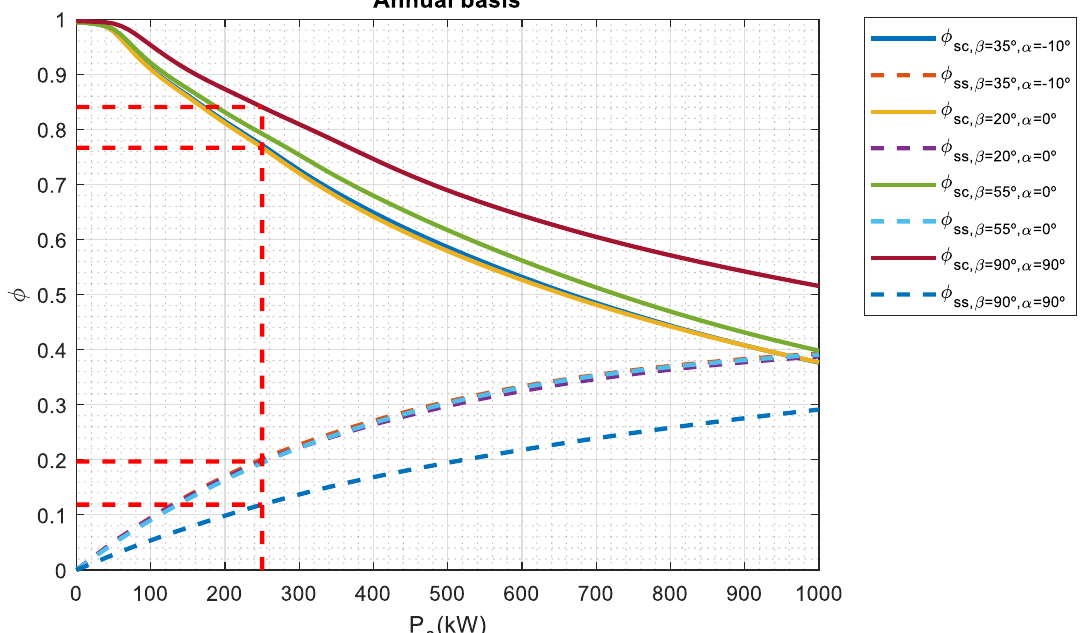
Figure 9 Annual basis. Self-consumption and self-sufficiency curves as a function of P 0 .